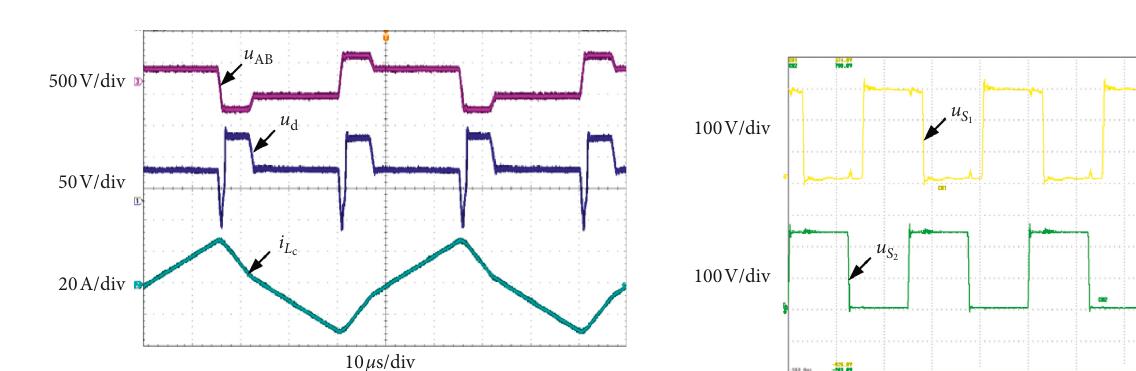
Figure 21: Waveforms of primary and secondary voltages and current of transformer under light load.